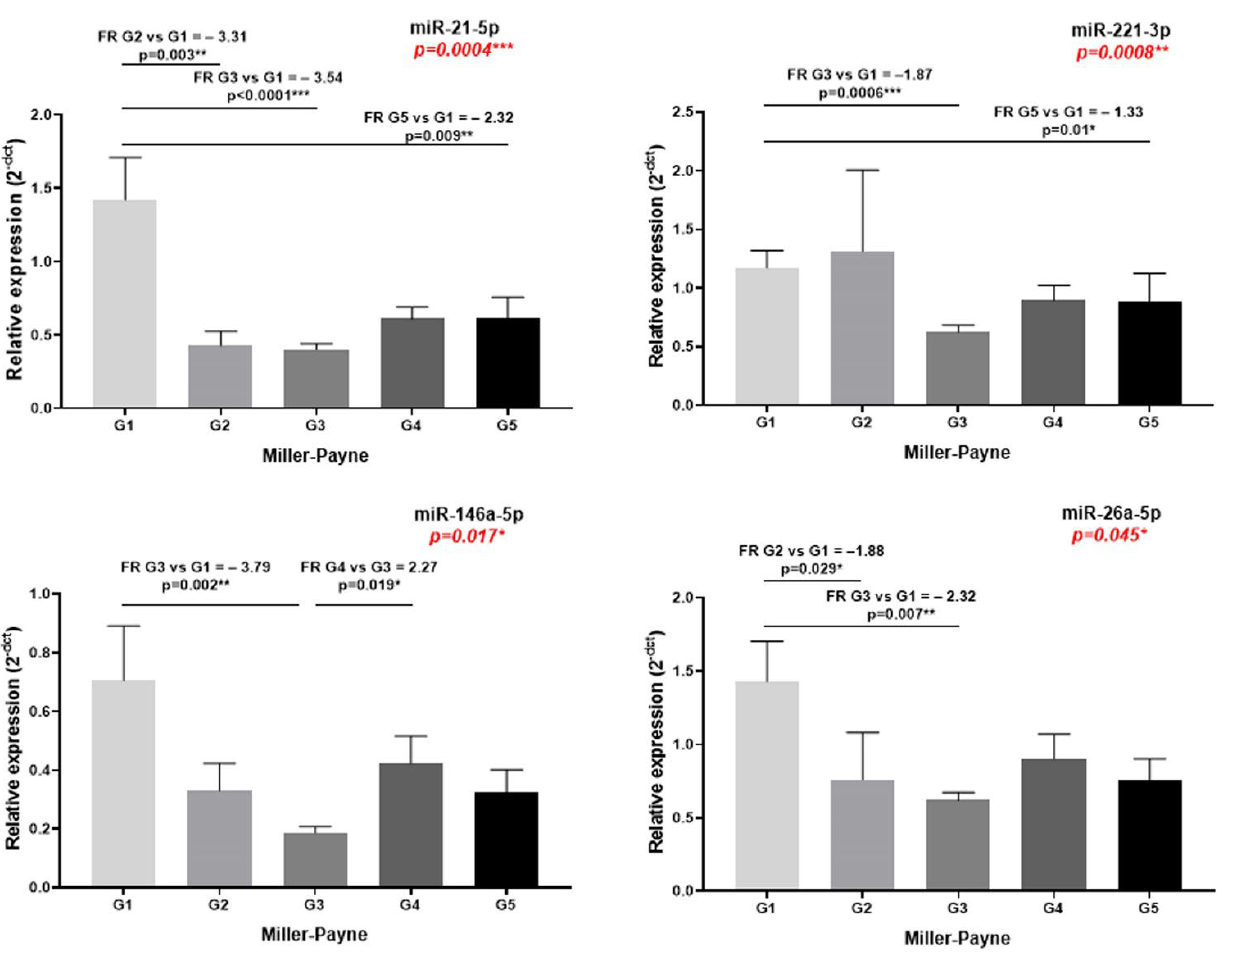
Figure 1. The miR-21-5p, 221-3p, 146a-5p and 26a-5p expression in plasma-derived sEVs, according to MP staging. The differences between groups were evaluated with Kruskal–Wallis test, and pairwise comparisons were performed with Dunn’s test (* p < 0.05, ** p < 0.01, *** p < 0.001).